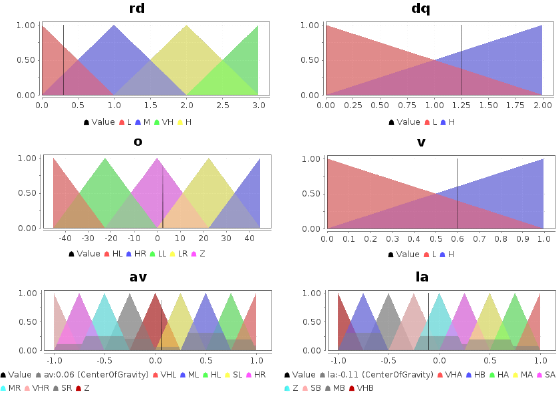
Fig. 9. Membership functions and defuzzification areas (light grey) for robots.fcl example.